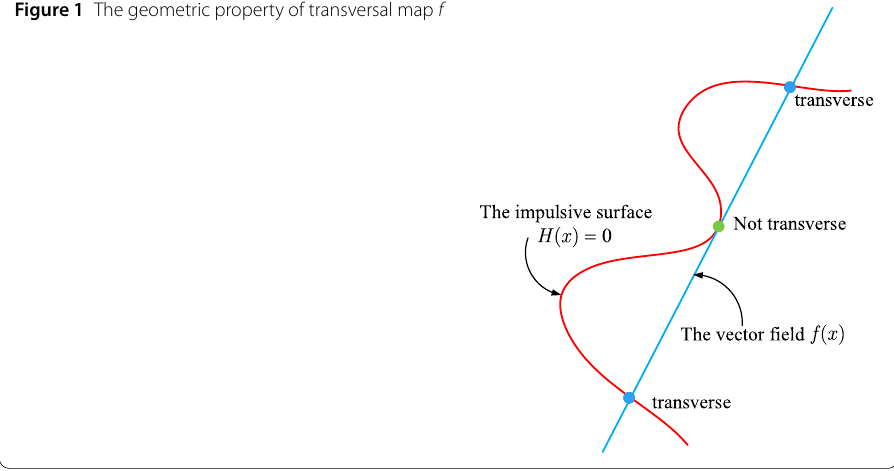
Figure 1 The geometric property of transversal map